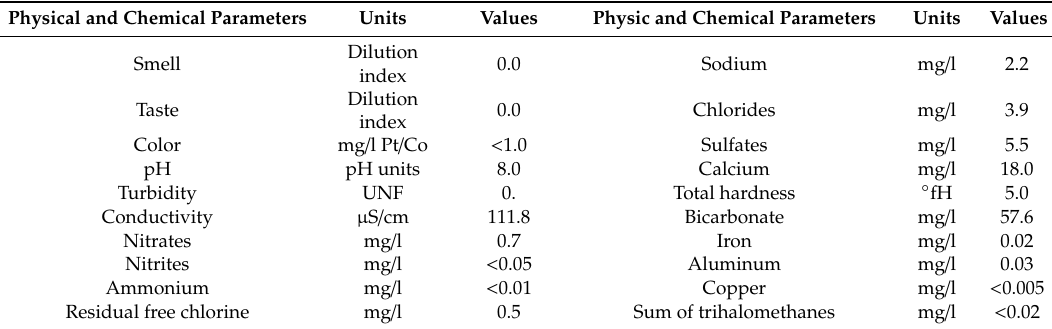
Table 2. Physical and chemical parameters of the water.